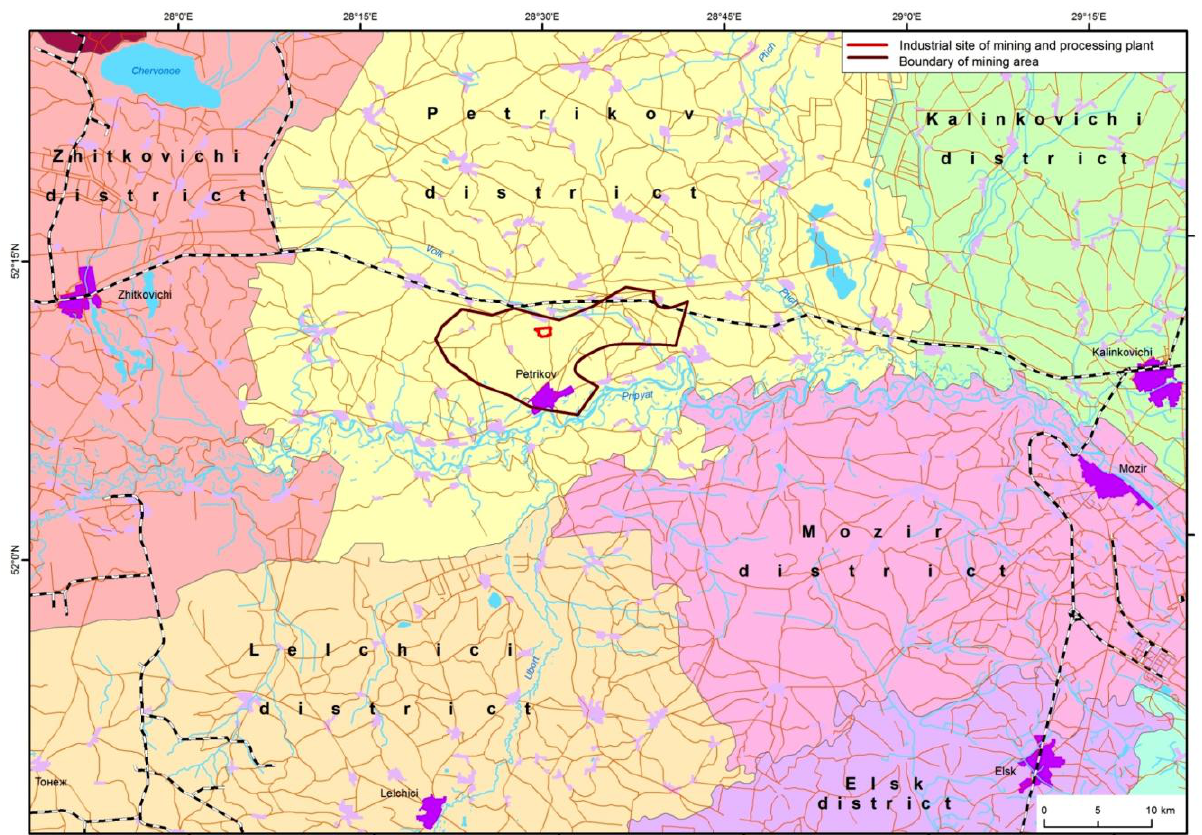
Fig. 1. General map of the Northern prospect of Petrikov potash